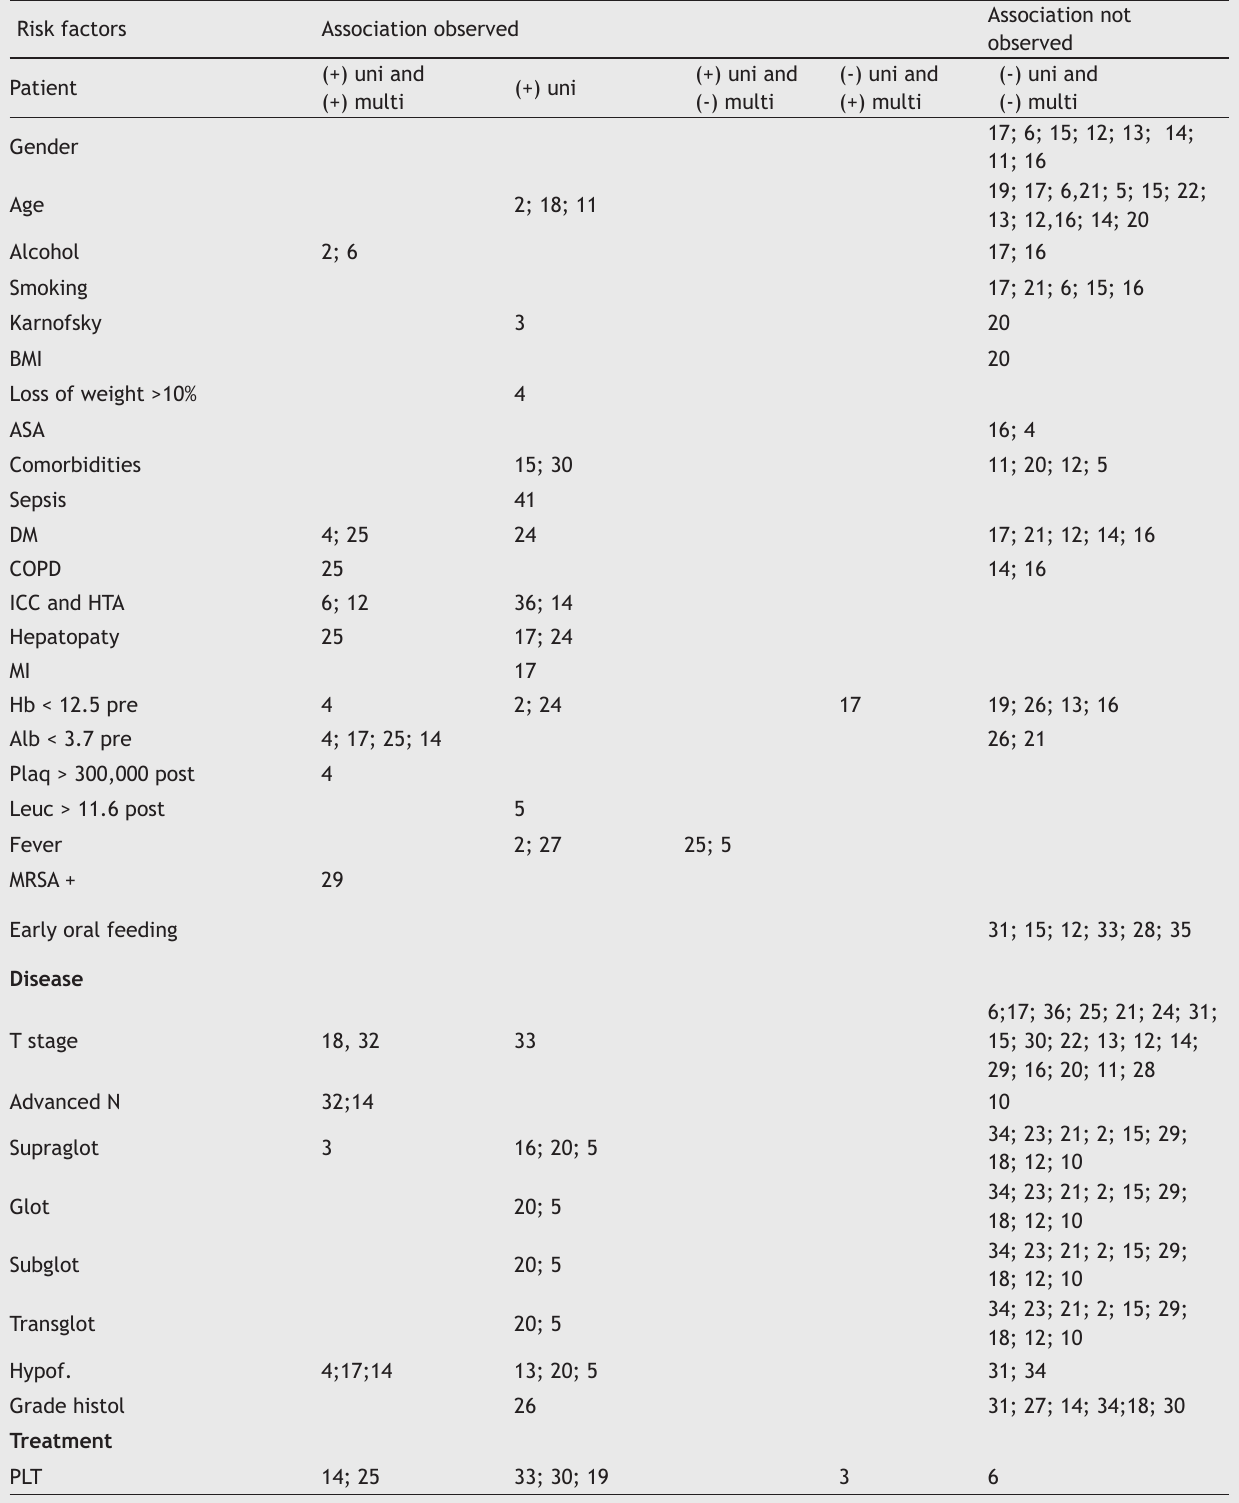
Table 2 Observed association between the presence of risk factors and development of pharyngocutaneous fistula with the univariate and multivariate analysis: (+) uni , observed association with univariate analysis and the multivariate analysis was not performed; (+) uni and (+) multi , an association was observed between the presence of risk factors and development of the pharyngocutaneous fistula in the univariate and multivariate analyzes; (+) uni and (-) multi , observed association in univariate analysis and it was not observed in multivariate analysis; (-) uni and (+) multi , an association was observed in the multivariate analysis and was not observed in the univariate analysis; (-) uni and (-) multi , no association was observed in the univariate and multivariate